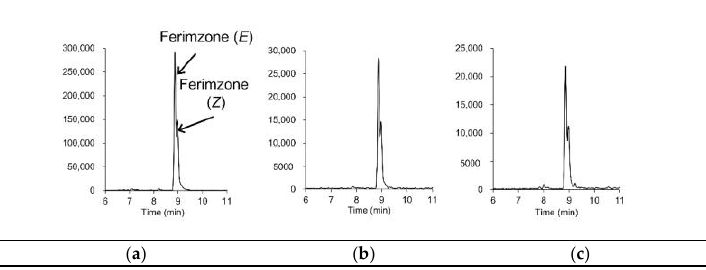
Figure 3. Extracted ion chromatograms (mass window ±5 mDa) of incurred ferimzone residue in a rice sample: ( a ) parent ion ([M+H] + , m/z 255.1604) and ( b , c ) its fragment ions (( b ) m/z 132.0808, ( c ) m/z